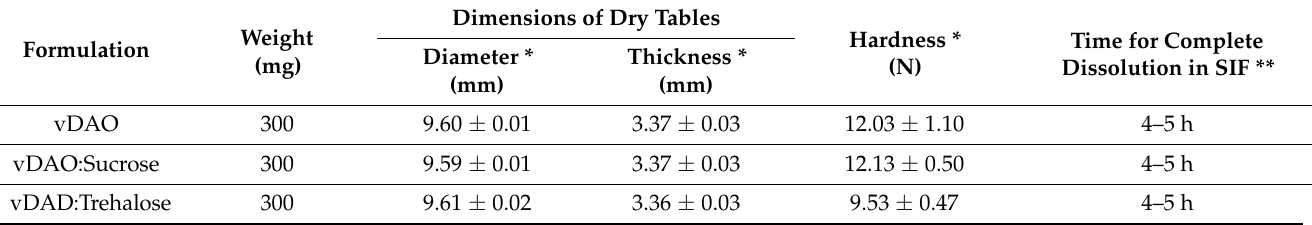
Table 2. Summary of the physical properties of the tablets.